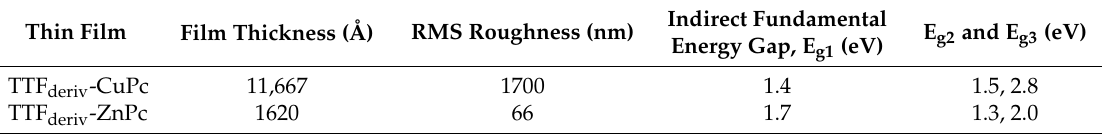
Table 2. Characteristic parameters of the TTF-MPc